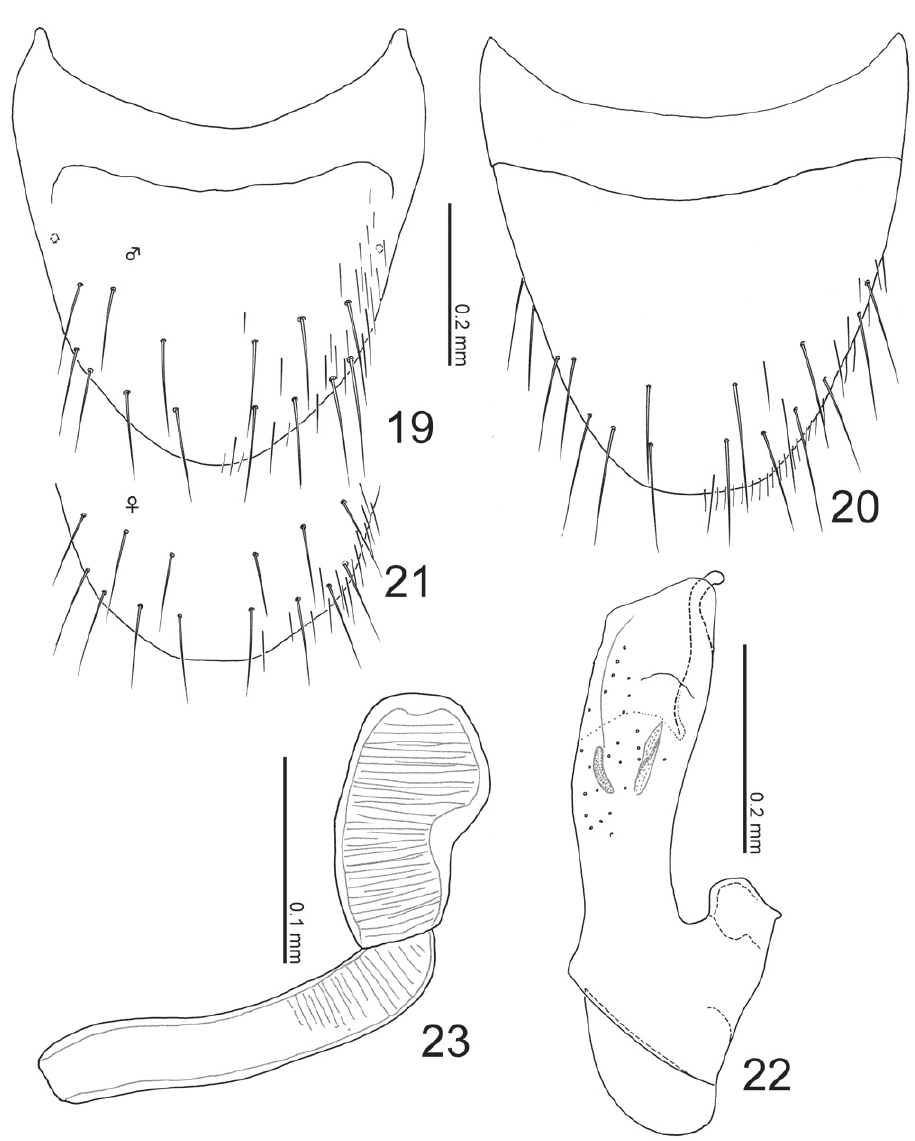
Figures 19–23. Terminalia of Leptogenophila roslii gen. et sp. n. 19 Male tergite VIII, dorsal view 20 male sternite VIII, ventral view 21 female tergite VIII, apical part, dorsal view 22 median lobe of aedea- gus, lateral view 23 Abdomen (Fig. 4) slightly expanded, widest around segment IV, well convex above; surface densely punctured, matte; segments II-IV emarginated posteromedially; seg- ments III and IV with a pair of large depressions around base,. Median lobe of aedeagus (Fig. 22) with apical lobe covered by exposed inner sac which is fused with apical mar- gin of aedeagus and well sclerotized. Paramere with apical lobe slightly widened apically.